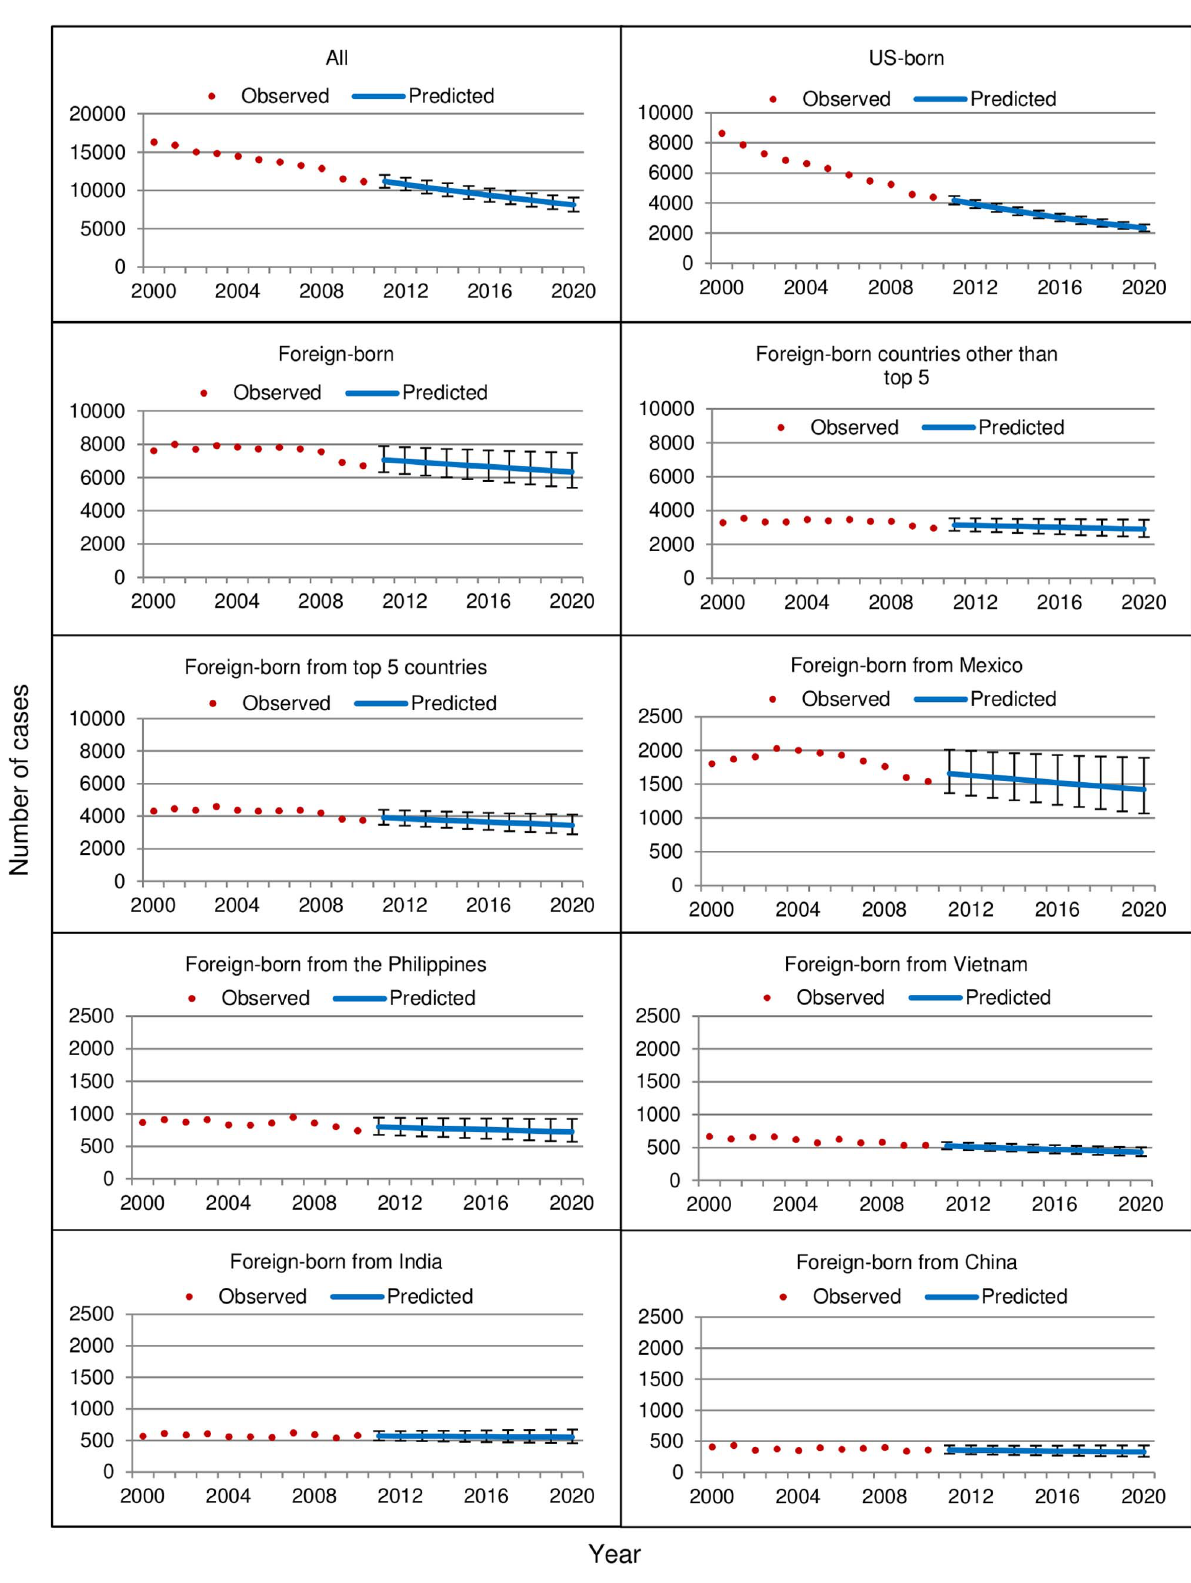
Figure 1. Comparison of observed and predicted tuberculosis (TB) case counts among select groups, United States, 2000–2020. Observed values for 2000–2010 reported to the National Tuberculosis Surveillance System were log transformed and logistic regression was performed on the log transformed counts to generate predicted values for 2011–2020. Vertical bars represent 95% prediction intervals.